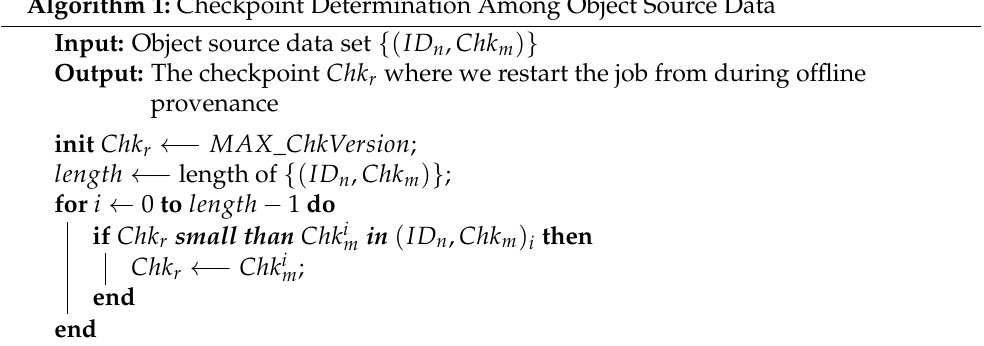
Algorithm 1: Checkpoint Determination Among Object Source